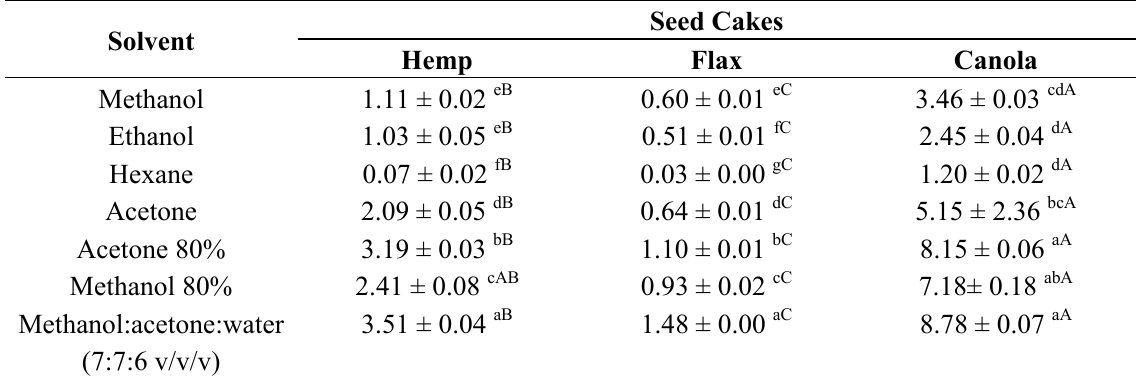
Table 4. Ferric reducing/antioxidant power (FRAP) assay ( μ mol Fe (II)/g fresh